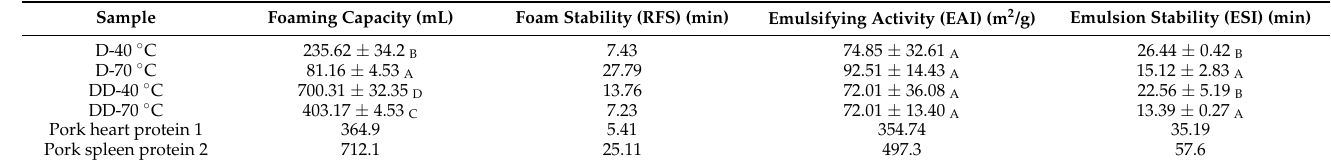
Table 6. Surface functional properties (foaming capacity; foam stability: RFS; emulsifying activity: EAI; emulsion stability: ESI) of porcine liver dried at 40 ◦ C (D-40 ◦ C) and 70 ◦ C (D-70 ◦ C) and subsequently defatted (DD-40 ◦ C and DD-70 ◦ C), compared to pork heart protein and pork spleen protein (pH 6.5).